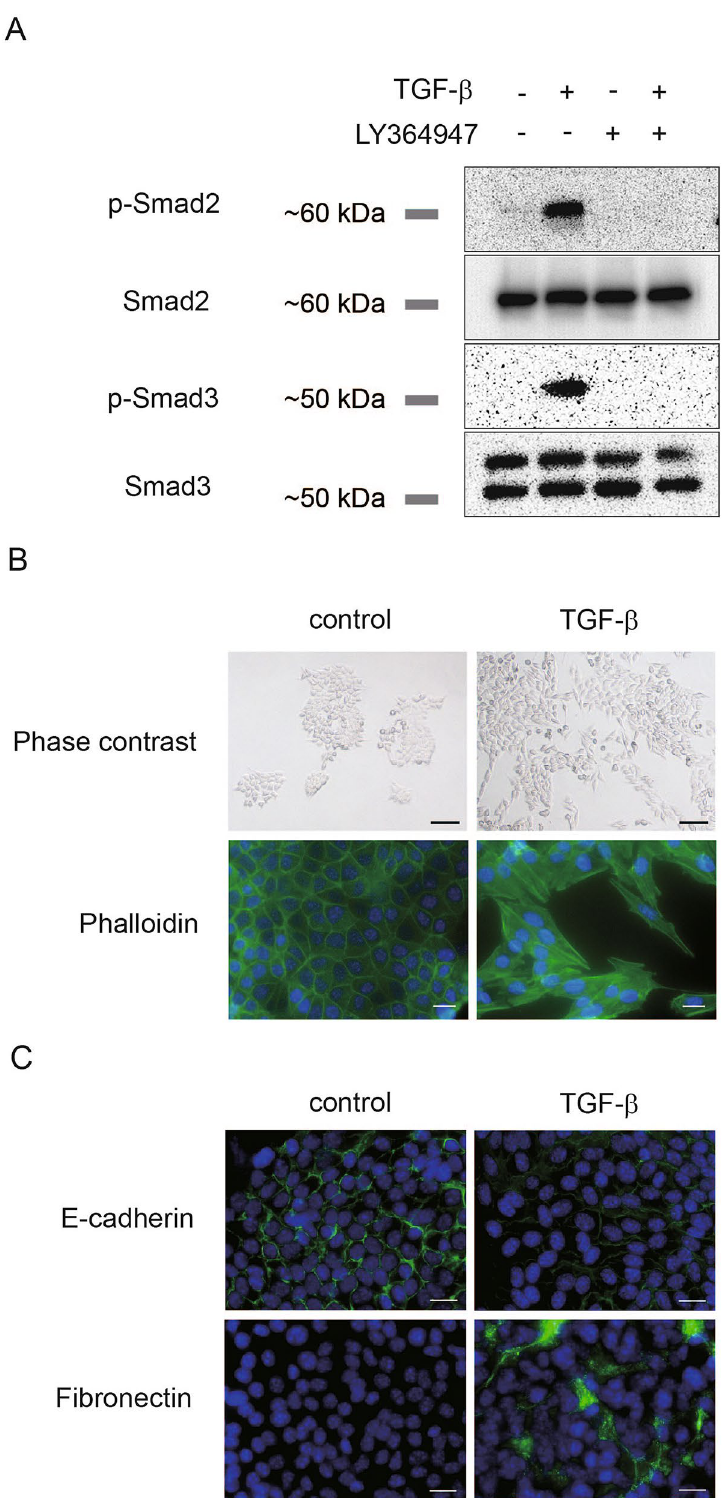
Figure 1. TGF-β induces EMT in CMT64 lung adenocarcinoma cells. ( A ) CMT64 cells were pretreated with 3 μM of LY364947, a TGF-β type I kinase inhibitor, or control DMSO, and were further stimulated with 5 ng/ml of TGF-β for 1 h. LY364947 or DMSO were added 1 h before TGF-β treatment. Immunoblotting was performed for phosphorylated Smad2 (p-Smad2; C-terminal region, Ser 465/467), total Smad2, phosphorylated Smad3 (p-Smad3; C-terminal region, Ser 423/425), and total Smad3. ( B ) CMT64 cells were cultured with or without 5 ng/ml TGF-β for 72 h. Upper: Cells were analyzed by phase-contrast microscopy (bar: 100 µm). Lower: Actin reorganization was visualized by phalloidin staining (bar: 20 µm). Green: phalloidin. Blue: DAPI (nuclei). ( C ) CMT64 cells were incubated with or without 5 ng/ml of TGF-β for 72 h. Immunocytochemistry for E-cadherin or fibronectin (green) was performed. Blue: DAPI